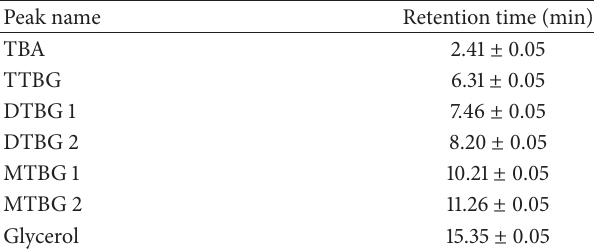
Table 2: GC retention time of each peak.